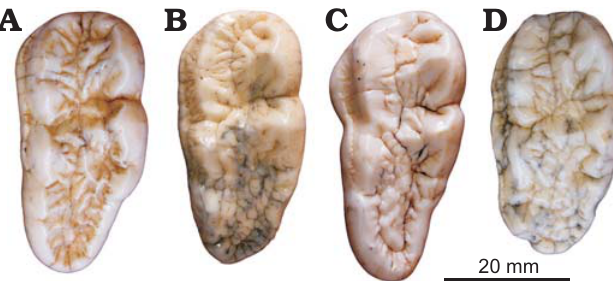
Fig. 7. Occlusal views of weakly separated RPa3 of Ursus deningeri Von Reichenau, 1904. A . NMP Rv21000, Kon ě pruské jeskyn ě . B . NMP Ra153, cave C718. C . NMP Ra2402, Chlum 1. D . NMP Rv20999, Kon ě pruské jeskyn ě . All from Czech Republic, early Middle Pleistocene. Photo Jan